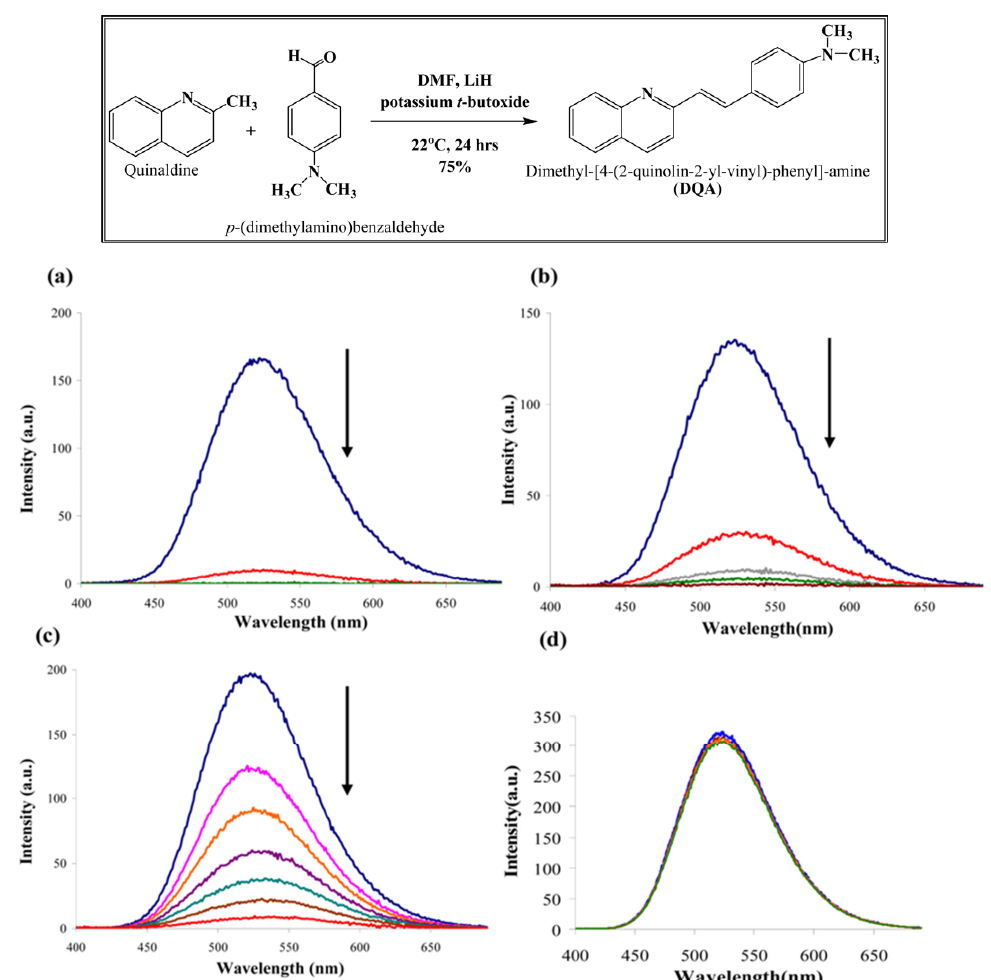
Figure 9. A schematic illustration of the synthesis of dimethyl-[4-(2-quinolin-2-yl-vinyl)-phenyl]- amine (DQA), an azastilbene chemosensor used for the evaluation of four different organophosphate pesticides in our laboratory. The fluorescence emissions spectra of DQA upon binding to four different OPPs (ethion, malathion, parathion and fenthion). ( a ) Titration with ethion; from top to bo tt om, concentration of ethion = 0, 2, 4, 6 µM; ( b ) titration with malathion; from top to bo tt om, concentration of malathion = 0, 2, 4, 8 µM; ( c ) titration with parathion; from top to bo tt om, concentration of parathion = 0, 2, 4, 6, 8, 10, 12 µM; and ( d ) titration with fenthion, with up to 24 µM of fenthion added, no change was observed. The direction of the arrow indicates the transformation in intensity of fl uorescence [18].